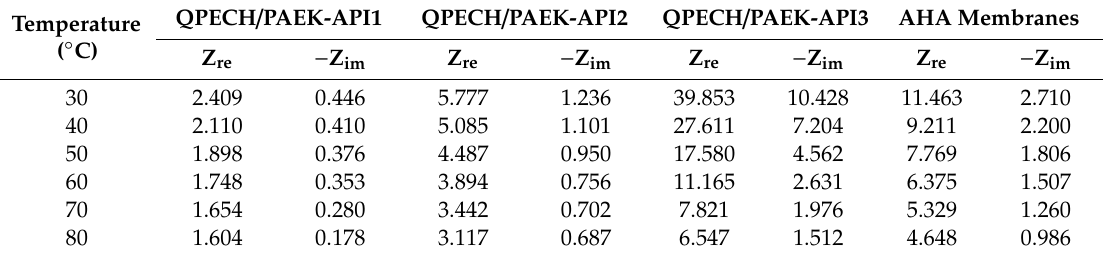
Table 2. The real and imaginary parts of the bulk resistance of membranes at di ff erent temperature.